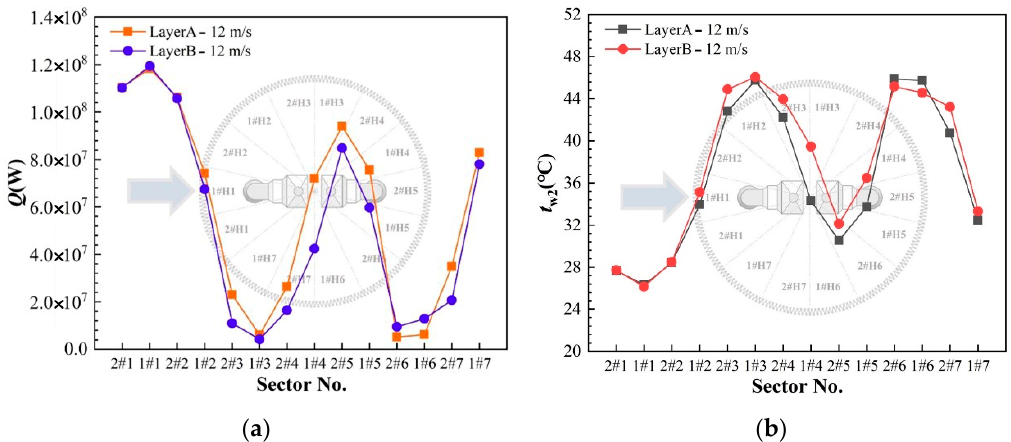
Figure 15. Heat rejections and water outlet temperatures of double-layer sectors under a typical crosswind of 12 m/s in the case of 2 units. ( a ) Heat rejections; ( b ) water outlet temperatures.